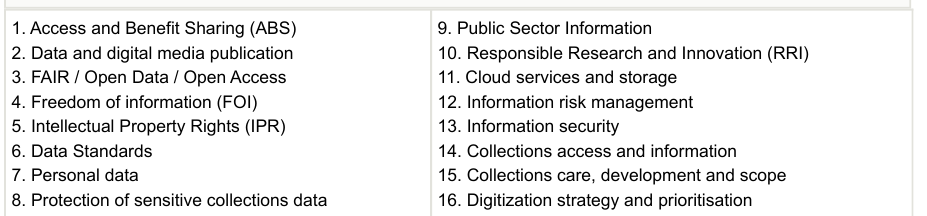
Table 5. Policy areas relevant to proposed activities of DiSSCo.